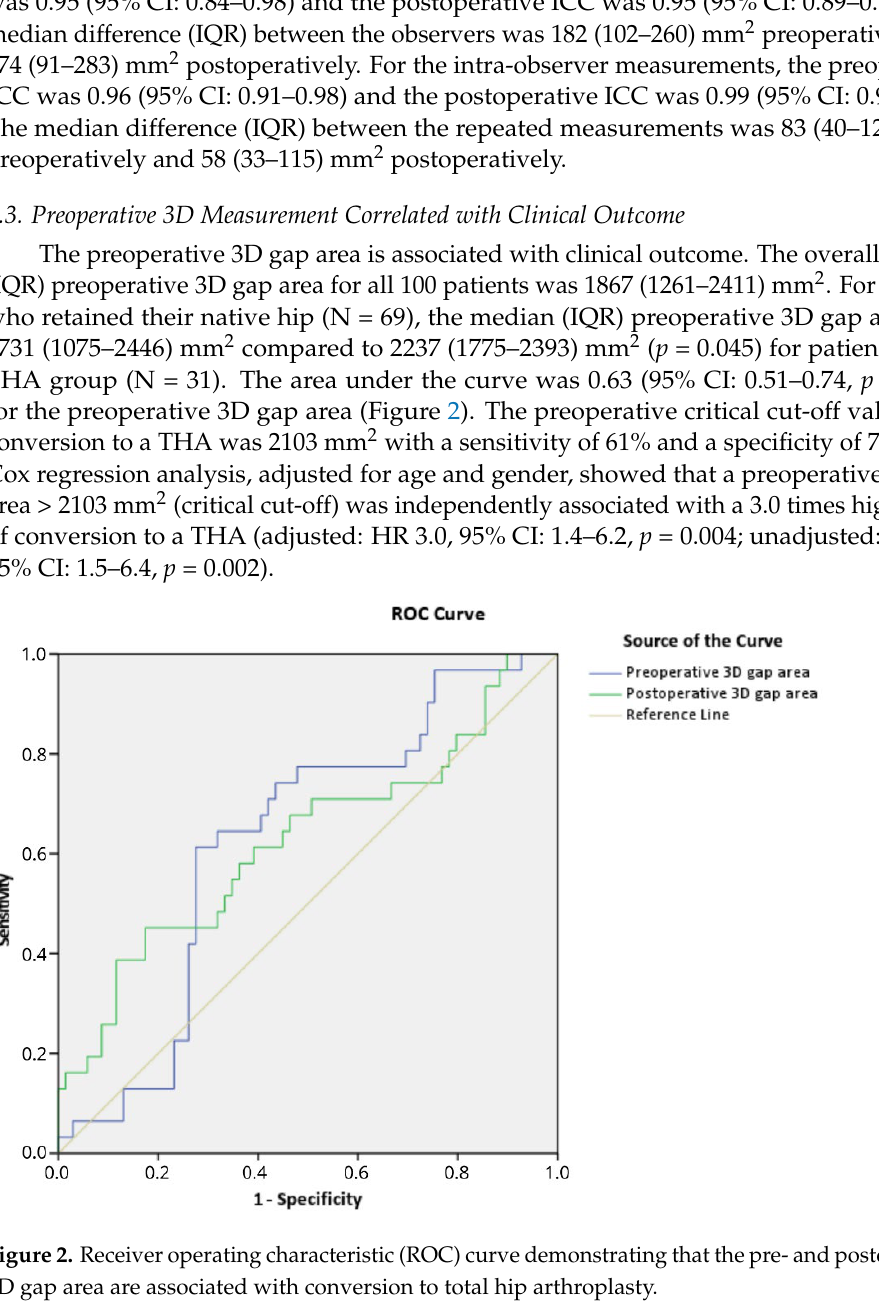
Figure 2. Receiver operating characteristic (ROC) curve demonstrating that the pre- and postopera- tive 3D gap area are associated with conversion to total hip